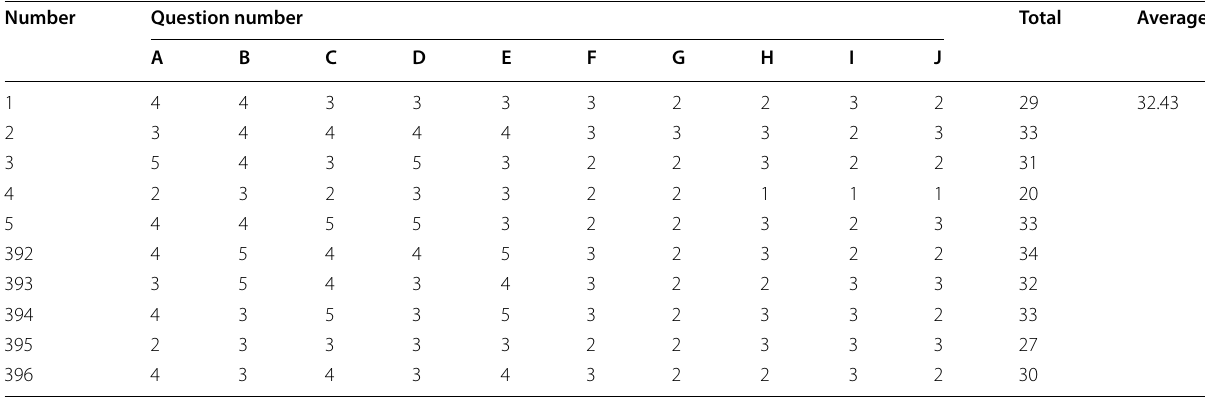
Table 6 Questionnaire Results (partial results)